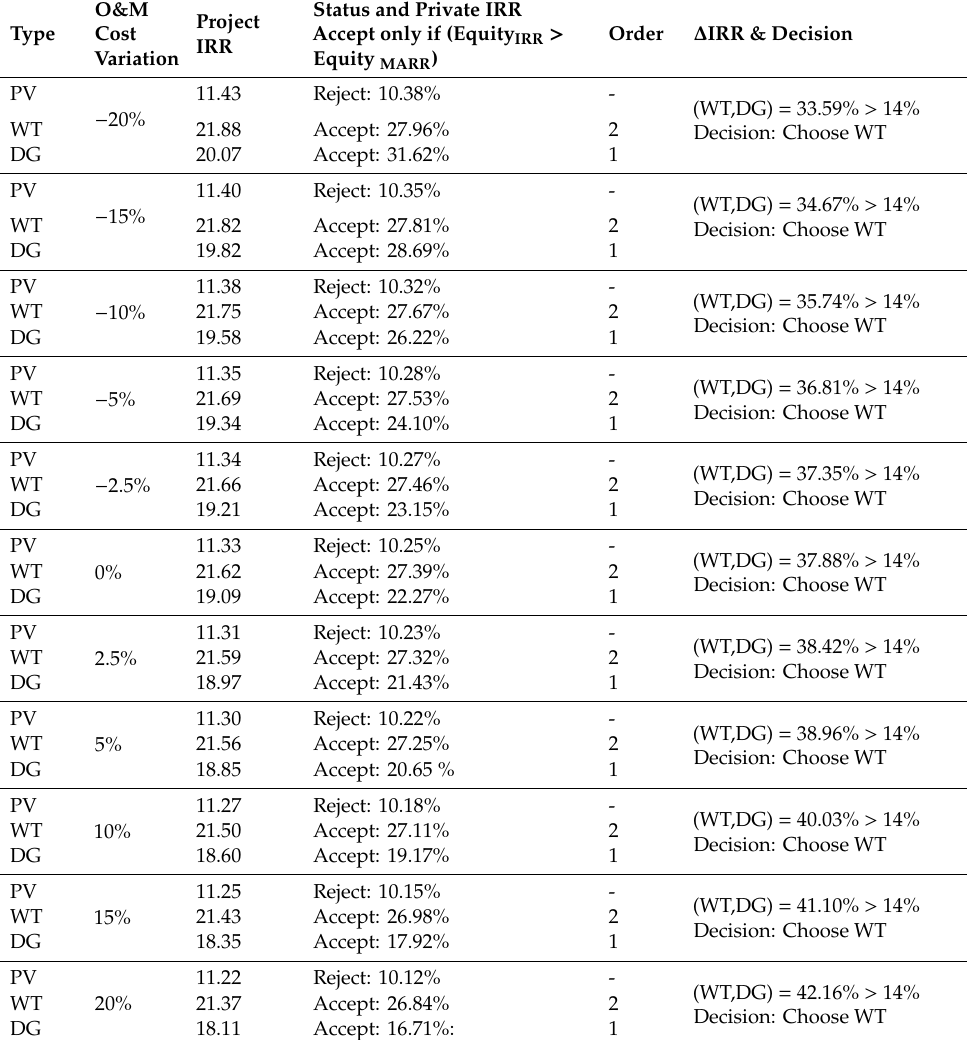
Table 5. Operation and maintenance cost variation e ff ect on